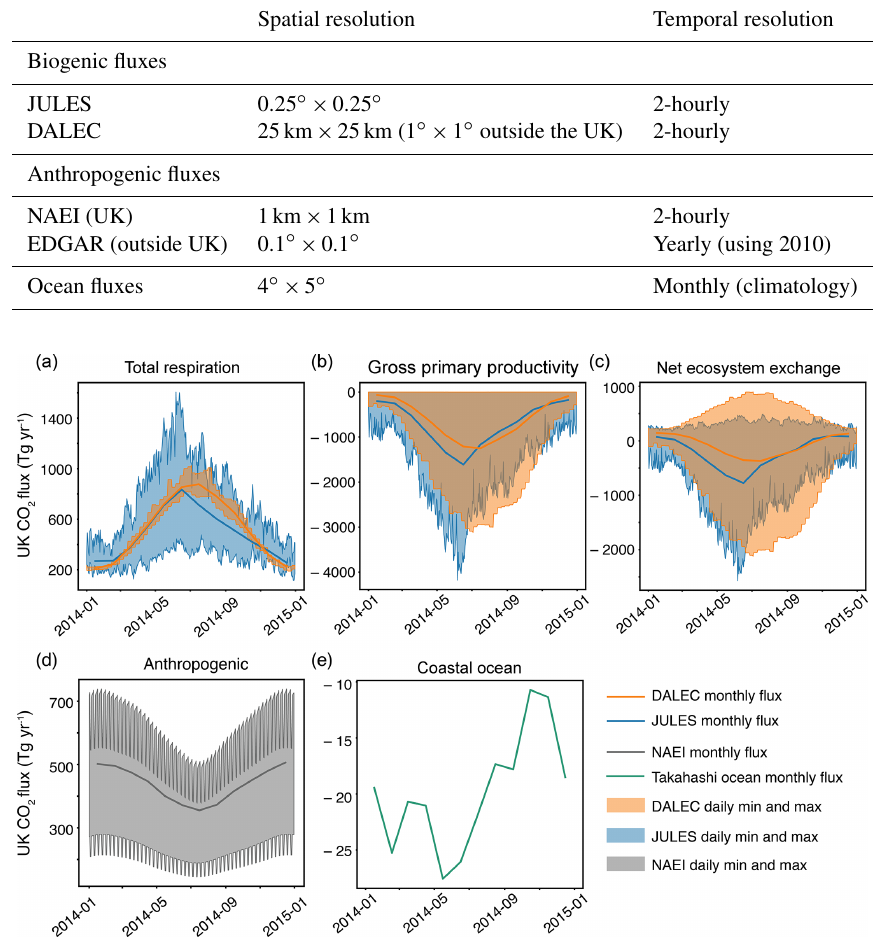
Figure 2. Prior UK fluxes in 2014. (a–c) Comparison of JULES (blue) and DALEC (orange) monthly fluxes and minimum and maximum daily values for TER, GPP and NEE respectively. (d) Monthly anthropogenic fluxes and minimum and maximum daily values from the NAEI inventory within the UK. (e) Monthly coastal ocean net fluxes from the Takahashi et al. (2009) ocean CO 2 flux